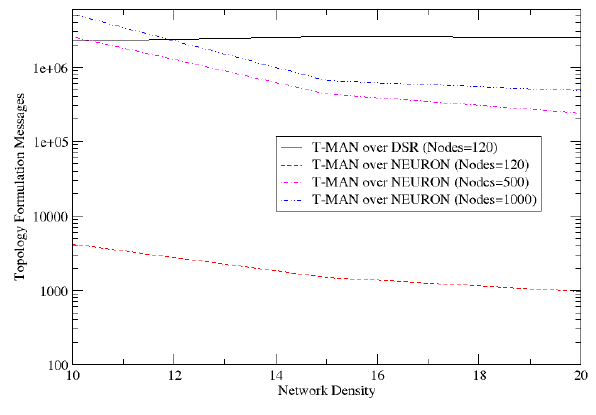
Figure 20. Routing Message Cost for Topology Formulation (logarithmic